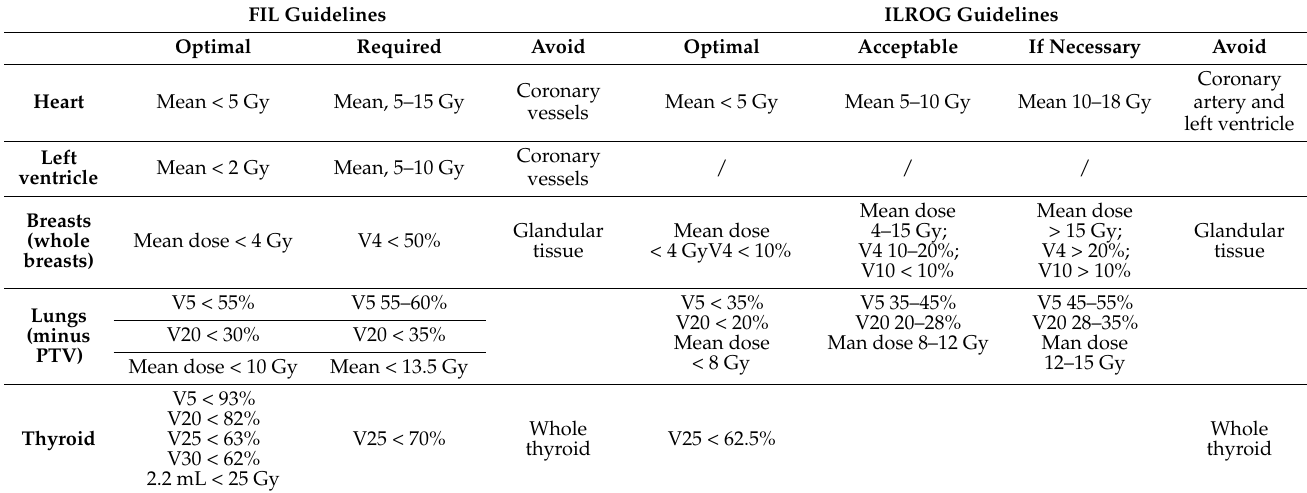
Table 1. Dose constraints to the organs at risk proposed by FIL (left) and ILROG (right) current guidelines for the treatment of Hodgkin